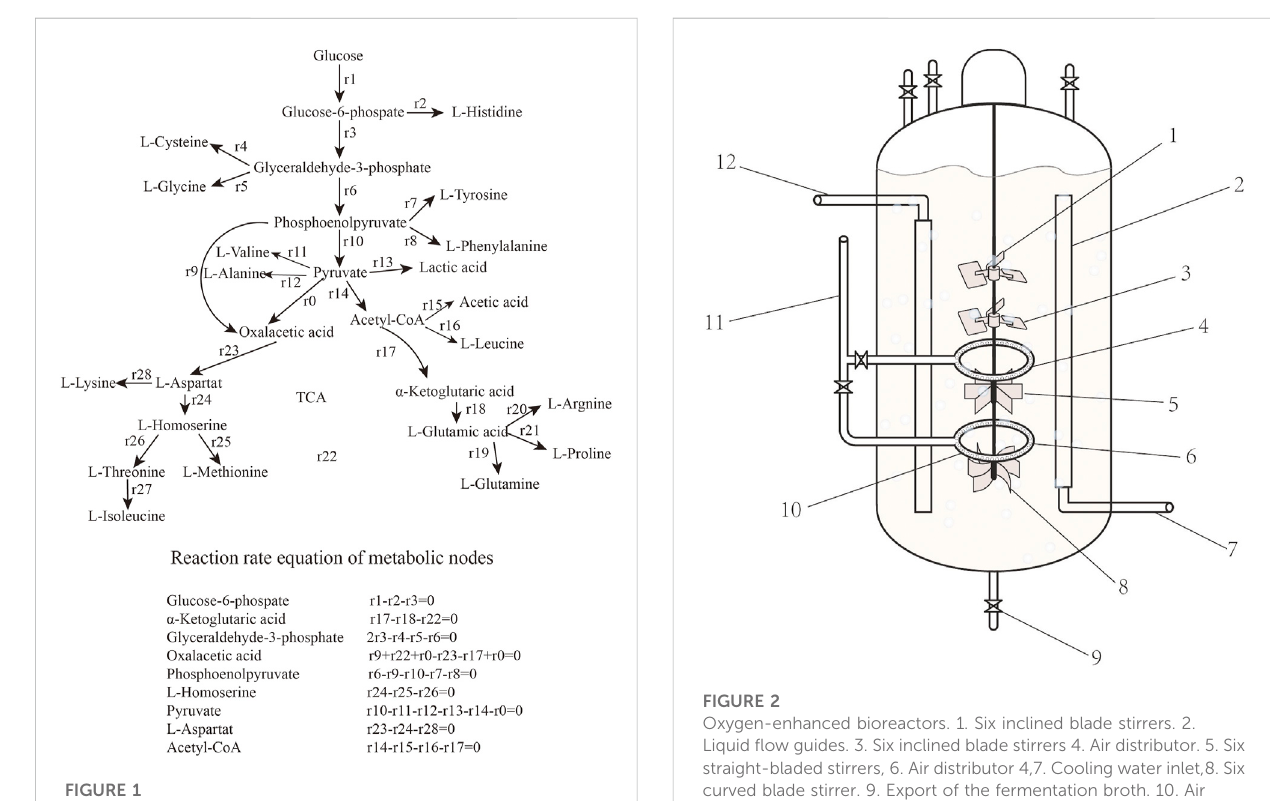
FIGURE 1 Metabolic networks and balancing equations.